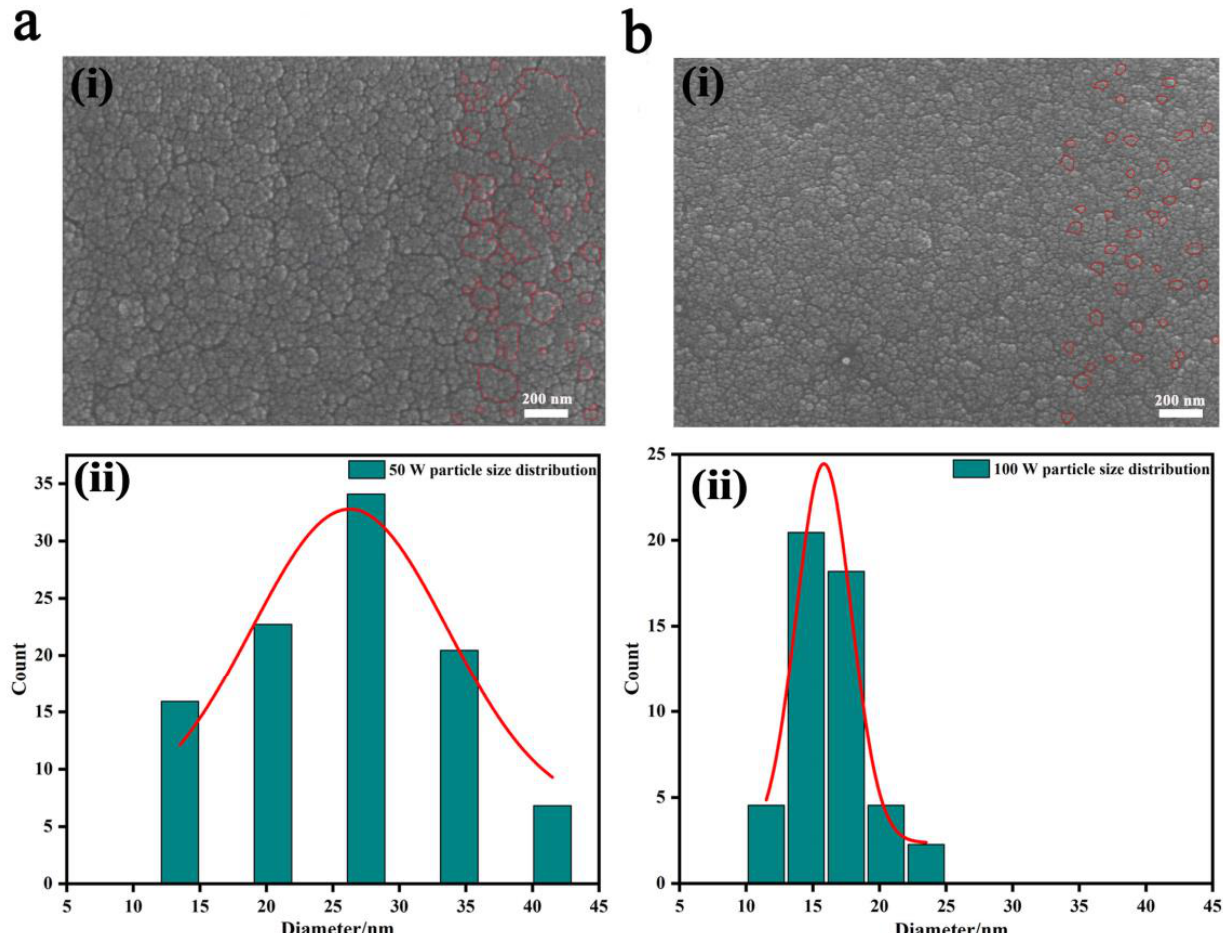
Figure 1. SEM images of the as-prepared WO 3 films and corresponding particle size distribution analysis through Nano Measure software; ( a ) 50 W; ( b ) 100 W, ( ai ) and ( bi ) are SEM images, where red line circles in ( ai ) and ( bi ) picture the particle size distribution, ( aii ) and ( bii ) are the histogram of particle size distribution. After Li ions’ insertion and the WO 3 film being fully colored, memory effects, i.e., the cation retention capability of the film electrodes, were recorded (Figure 2aii,bii). When the films were as-colored, transmittance modulation rates at the wavelength of 550 nm were 73% (from 78.3% to 5.3%) for the 50 W-deposited WO 3 film and 76% (from 77.8% to 2.1%) for the 100 W-deposited film. After being exposed in the air for 24 h, the transmittance modulation rate decreased by 26% (from 73% to 47%) for the 50 W-deposited film and 21% (from 76% to 55%) for the 100 W-deposited film. Thus, a better cation retention capability would be achieved for the compact WO 3 film, but optical performances of the two films were overall equivalent. In addition, in adhesive force tests with the ITO substrates, the two films also performed fairly, and the adhesion factors f were both 1, meaning excellent adhesive situations between the WO 3 films and the ITO substrates were achieved from the magnetron sputtering method, which inherently provides good adhesion with substrates (Figure